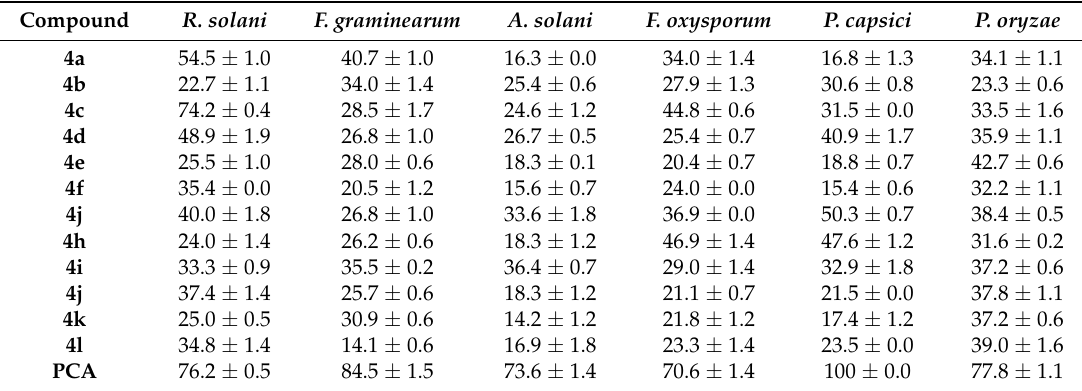
Table 1. In vitro fungicidal activities of title compounds against six pathogenic fungi. Compound